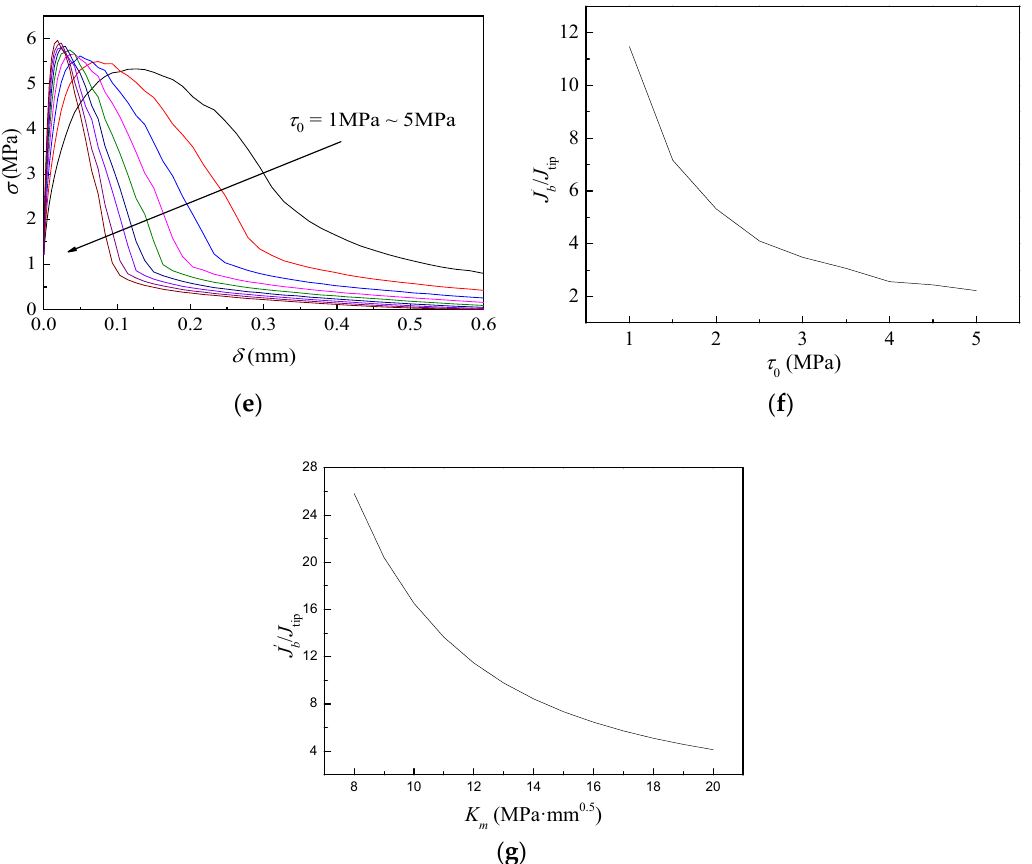
Figure 1. Effects of the analytical parameters on the fiber bridging stress-crack opening width ( σ-δ ) curve and performance indicator ( J b ′/ J tip ). ( a ) Effect of fiber volume fraction ( V f ) on σ-δ curve; ( b ) V f vs. J b ′/ J tip ; ( c ) effect of chemical bond ( G d ) on σ-δ curve; ( d ) G d vs. J b ′/ J tip ; ( e ) effect of frictional bond ( τ 0 ) on σ-δ curve; ( f ) τ 0 vs. J b ′/ J tip ; ( g ) fracture toughness of matrix ( K m ) vs. J b ′/ J tip .